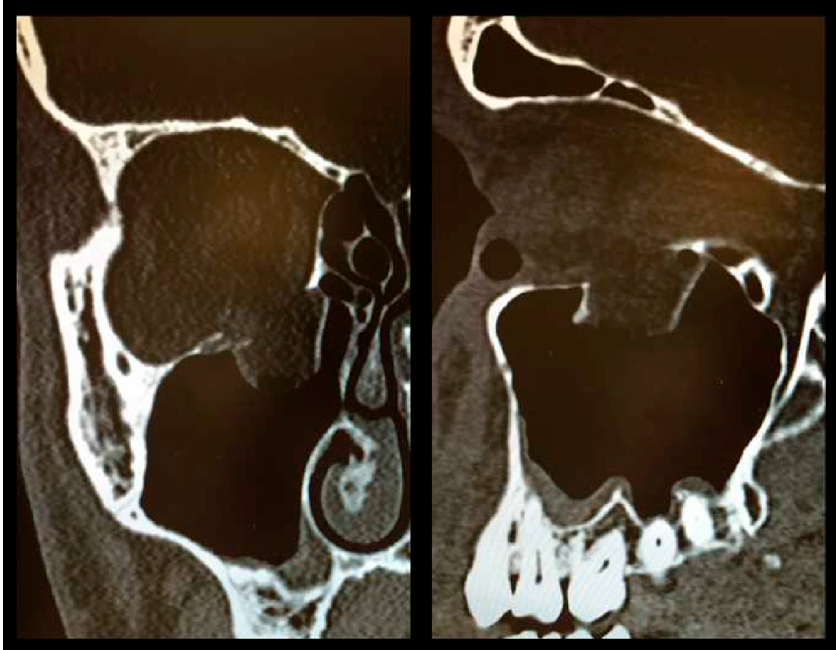
Figure 2. Preoperative CT scan showing a large OFF (( left ) coronal view, ( right ) sagittal view).